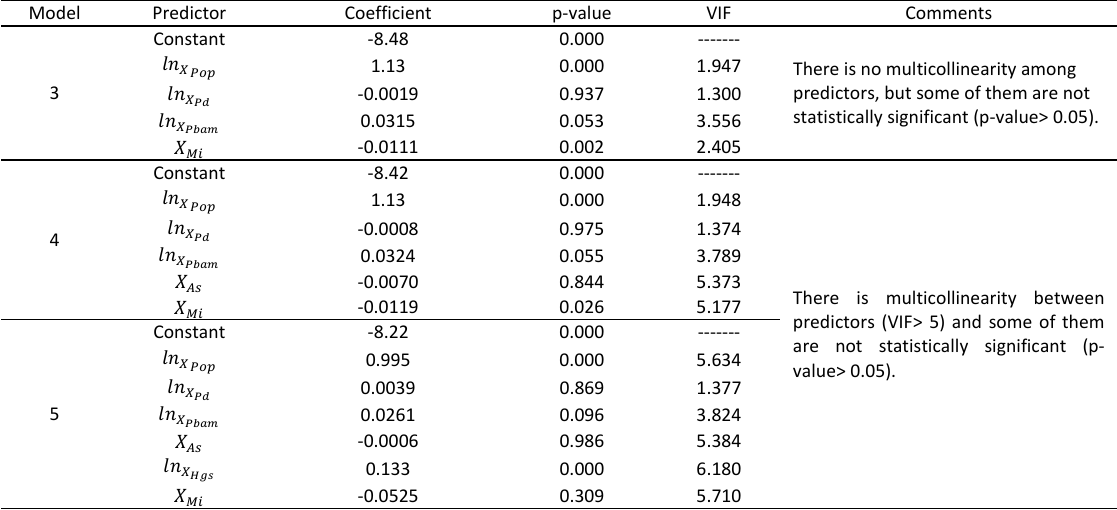
Table 6: Statistical behavior of predictors in models 3, 4 and 5